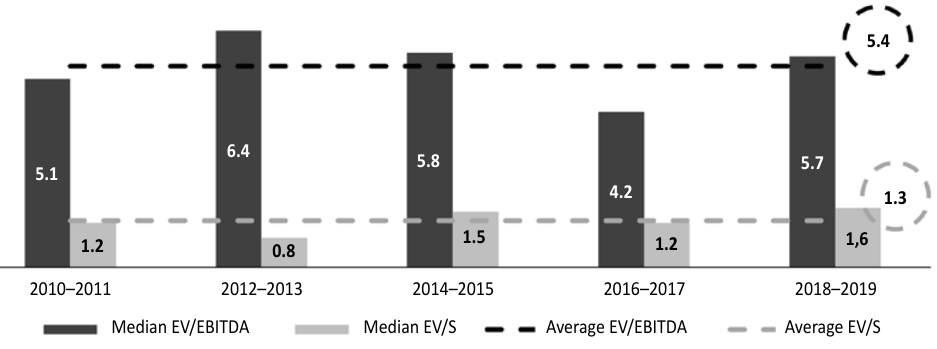
Source: own elaboration based on Kolarova et al. (2020, p.